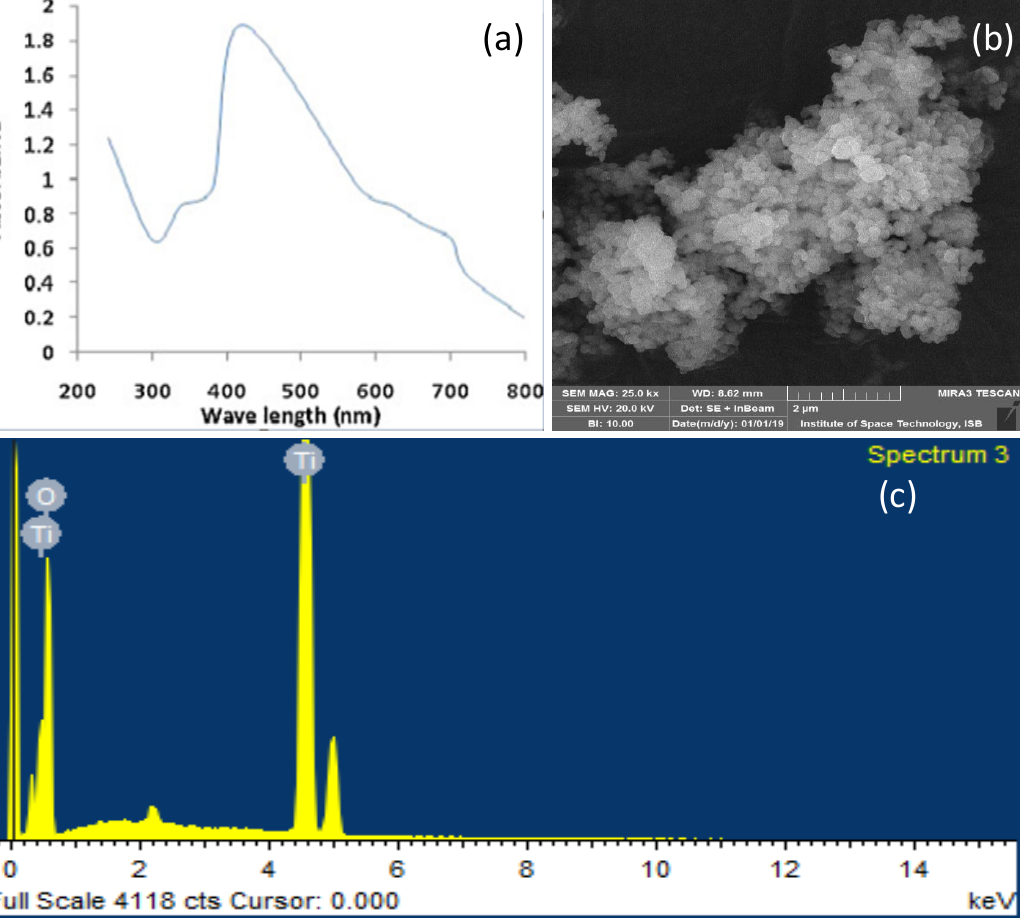
Figure 1. Green synthesized TiO 2 NPs were characterized using ( a ) UV-visible spectrum ( b ) scanning electron microscope (SEM) ( c ) energy dispersive x-ray (EDX) spectroscopy. Treatment with plant based TiO 2 NPs enhanced the germination attributes of wheat plants under salinity stress. The application of 50 µg/mL TiO 2 NPs at 50 mM NaCl solution showed increases of 72.26% and 68.11% in the germination percentage, 67.28% and 61.35% in the germination index, 58.12% and 51.18% in the seedling vigor index, 34.32% and 27.21% in the seedling length, and 30.24% and 25.42% in the fresh weight, for both wheat varieties, respectively. Similarly, treatment with 50 µg/mL TiO 2 NPs at 100 mM salt solu- tion increased the germination percentage by 65.04% and 59.21%, the germination index by 61.14% and 49.33%, the seedling vigor index by 45.04% and 39.10%, the seedling length by 28.42% and 22.24%, and the fresh weight by 26.16% and 19.26%, for both wheat varie- ties, respectively. The application of 50 µg/mL TiO 2 NPs at 150 mM NaCl solution, showed a 45.13% and 41.27% increase in the germination percentage, a 35.76% and 27.92% increase in the germination index, a 30% and 27% increase in the seedling vigor index, a 25.63% and 21.29% increase in the seedling length, and a 17.72% and 12.27% increase in the fresh weight, of both wheat varieties, respectively. In addition, application of 50 µg/mL TiO 2 NPs alone, showed a remarkable increase in the germination percentage (15.82% and 10.16%), the germination index (10.25% and 7.31%), the seedling vigor index (12.15% and 9.55%), the seedling length (15.36% and 11.59%), and the seedling fresh weight (8.35% and 6.78%), for both wheat varieties, respectively, compared to their respective controls.